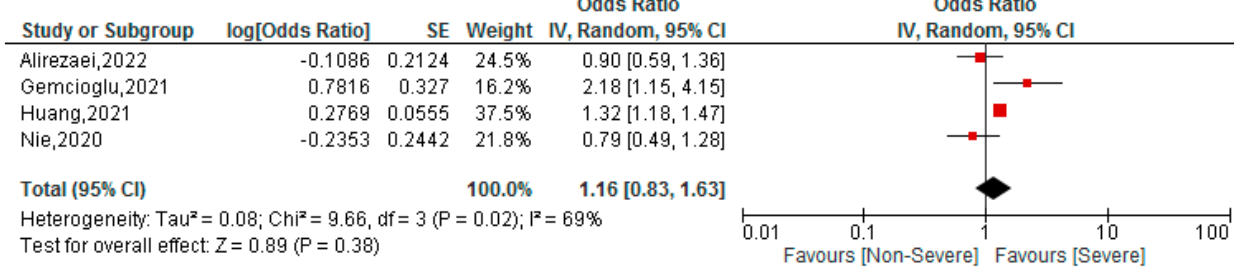
Figure 4. Association between BAR and severity of COVID-19 patients [33,44,45,49].